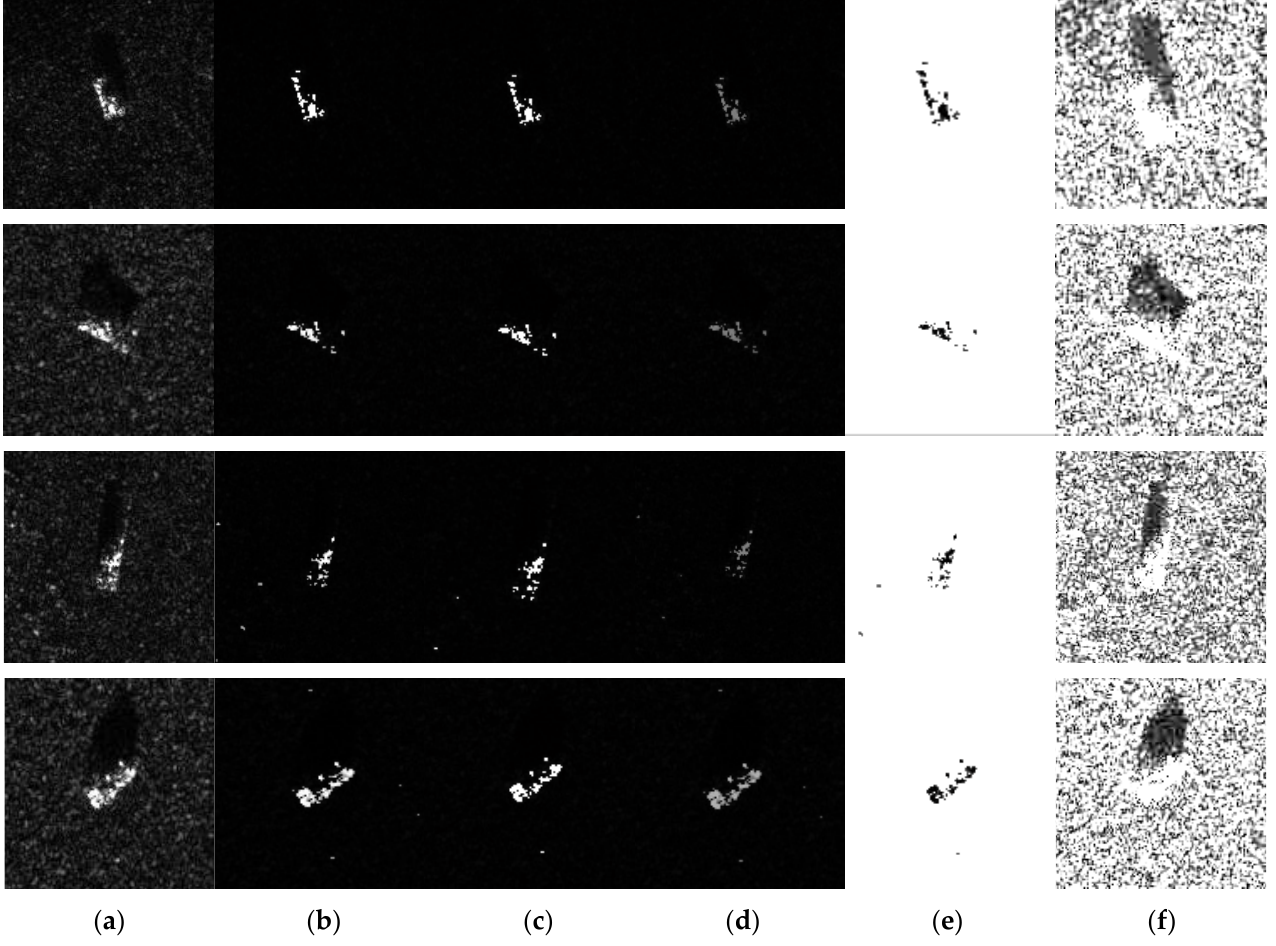
Figure 15. Four class samples: ( a ) original image; ( b ) the fusion ratio is 1:10; ( c ) target enhancement; ( d ) target reduction; ( e ) target segmentation; ( f ) target shadow region location.